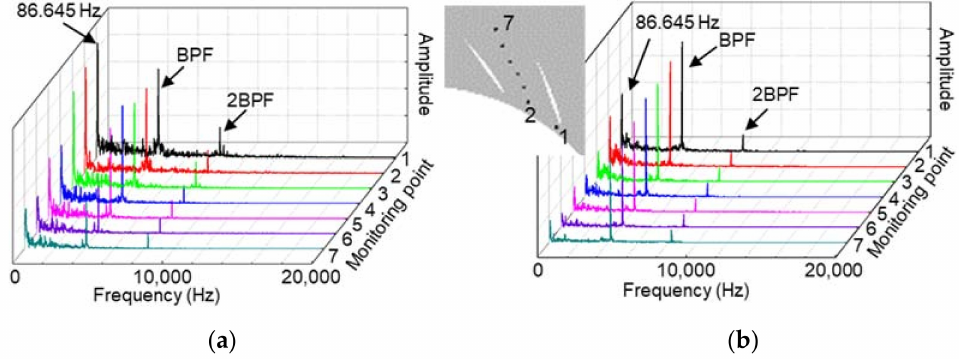
Figure 14. Spectrum results at different locations ( ϕ = 0.7 Q d ): ( a ) TVD; ( b )